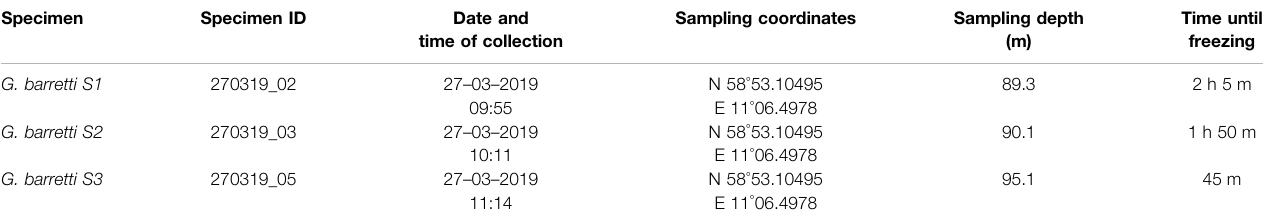
TABLE 1 | Summary of sampling conditions for the three Geodia barretti specimens. Specimen Specimen ID